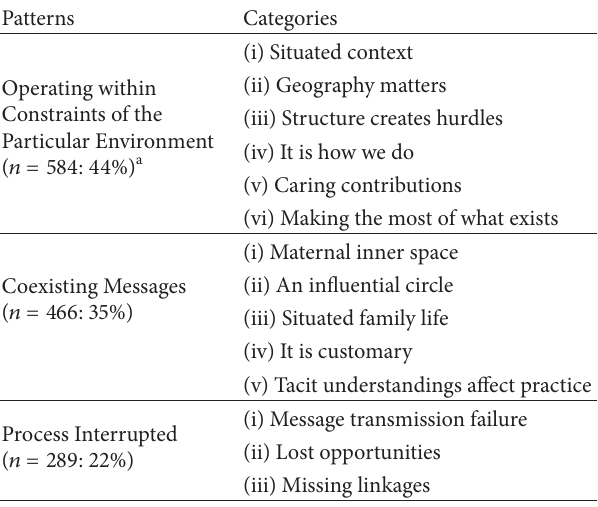
Table 1: Patterns found in HCWs understandings of community breastfeeding supports and